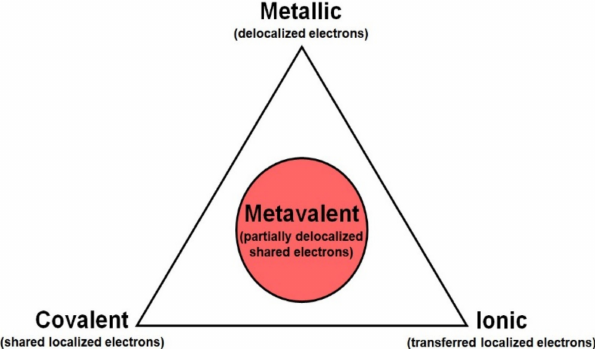
Figure 5. Modified van Arkel bond-type triangle. Ionic, covalent, metallic, and metavalent bondings are shown depending on the degree of electron